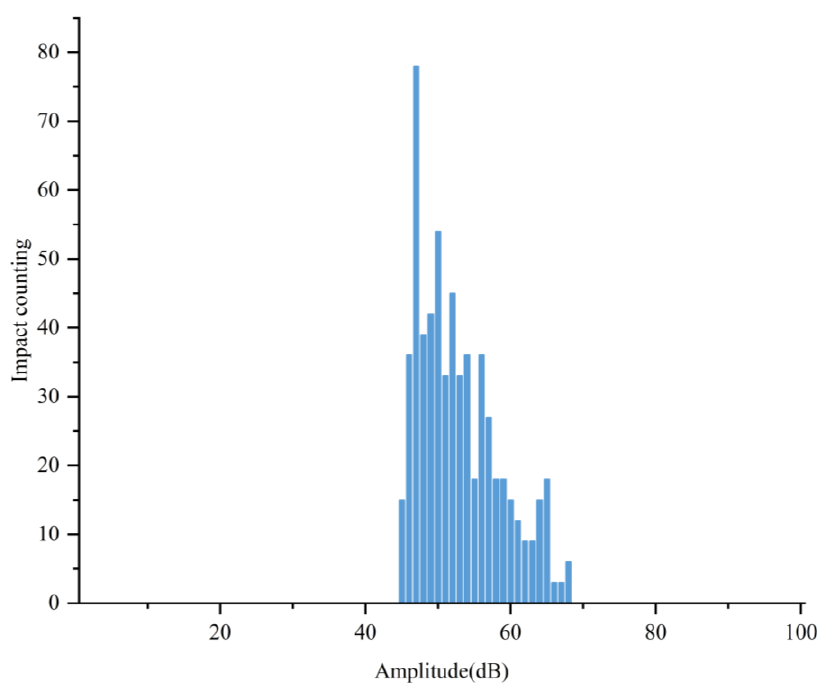
Figure 8. Impact-amplitude correlation diagram of cable noise signal of Yangma Island Bridge.